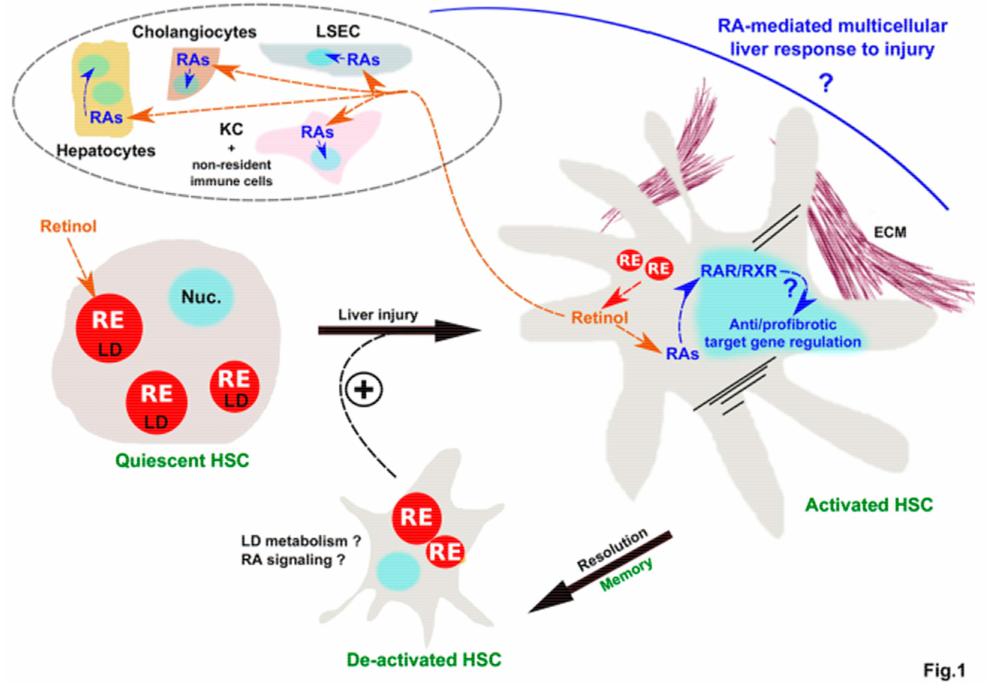
Figure 1. Potential role of RAs derived from the loss of RE-filled HSC LDs as an orchestrator of a multicellular response to liver injury. Schematic showing the basis for the proposal that RAs derived from the loss of RE-filled LD upon HSC activation may define a multicellular response to liver injury. Outstanding questions are indicated by question marks. See text for details. ECM, extracellular matrix; KC, Kupffer cells; LD, lipid droplet; LSEC, liver sinusoidal endothelial cells; Nuc., nucleus; RE, retinyl ester; RAs, retinoic